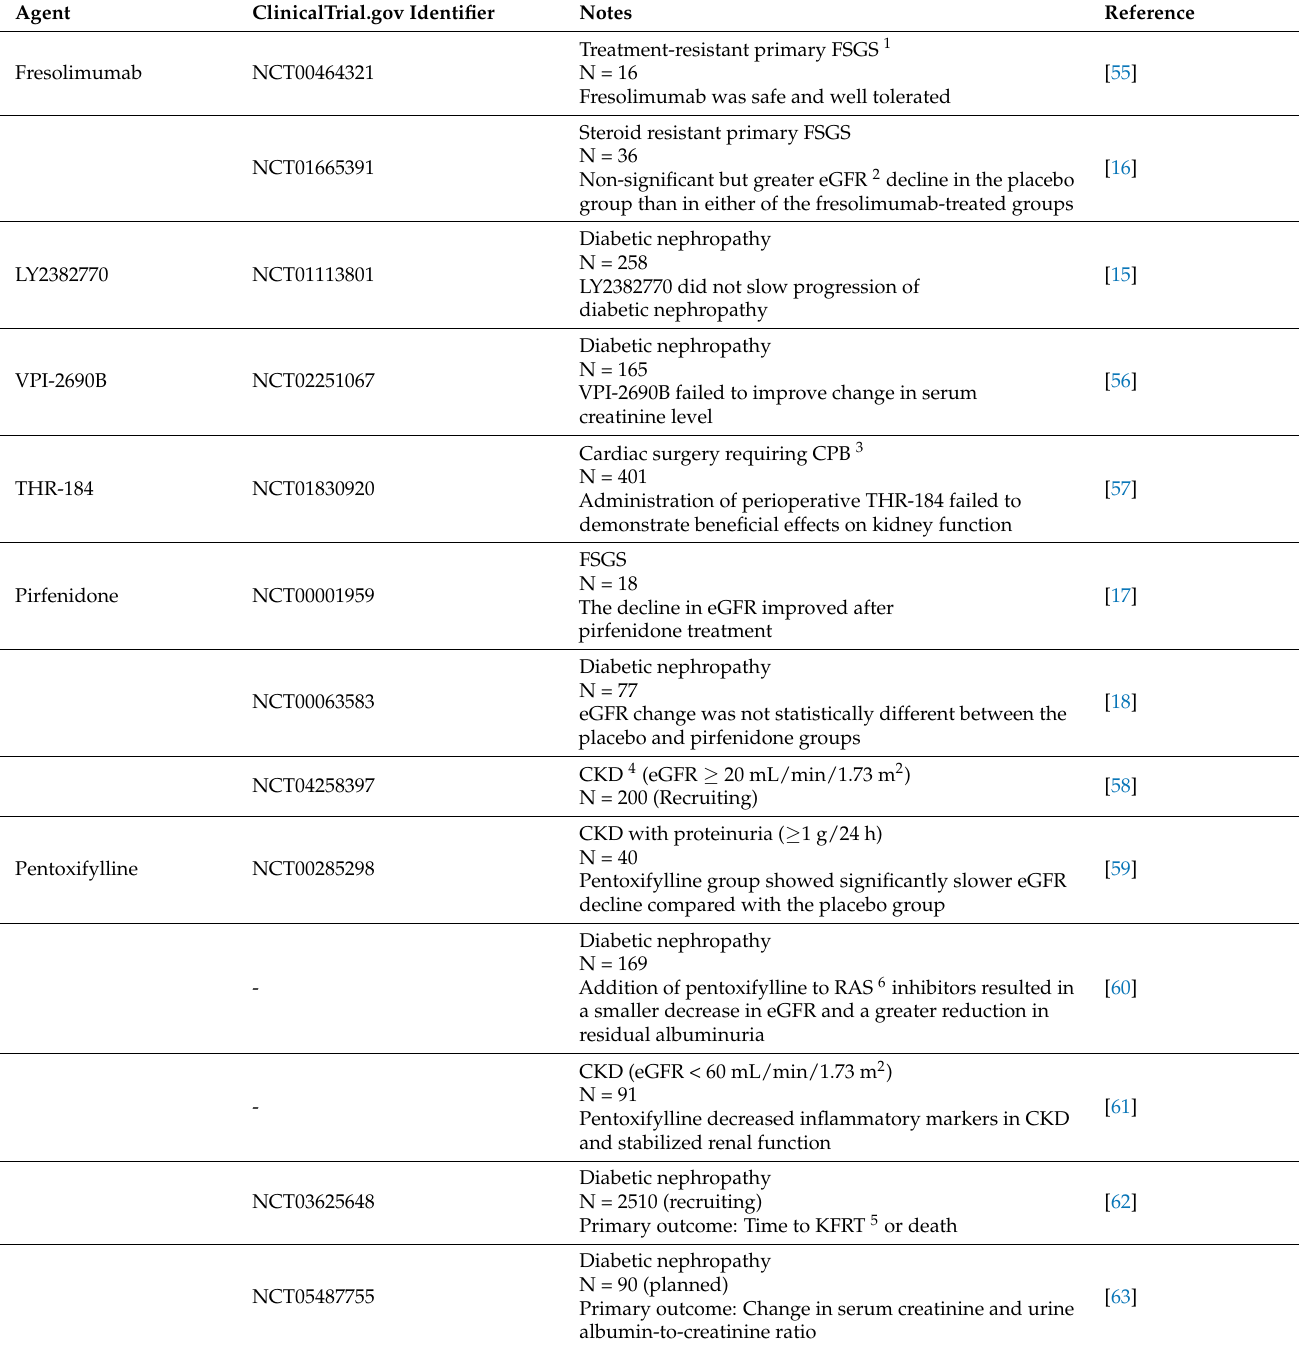
Table 1. Overview of studies for TGF- β or TGF- β signaling pathway inhibitors in patients with kidney